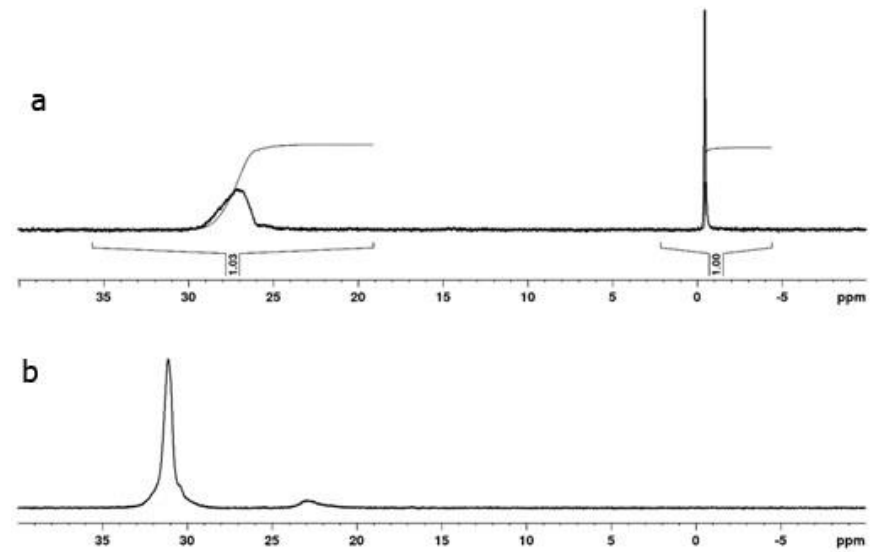
Figure 7. 31 P NMR spectra of the mixture of MAG–VPA copolymer with MPC ( a ) and PVPA ( b ) in D 2